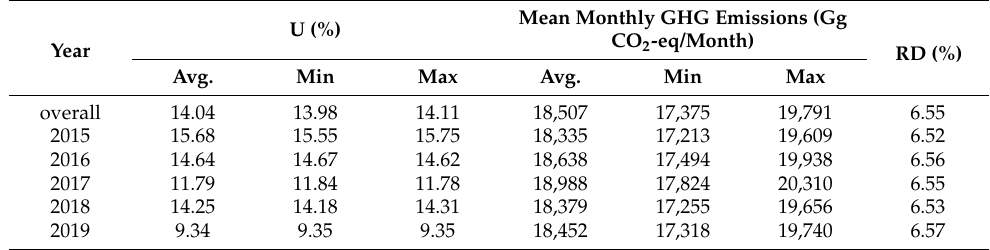
Figure 4. Box plot ( a ) and 95% family-wise confidence level ( b ) Differences in mean levels of Treatment. Table 3. The U, mean, and RD of the monthly GHG emissions based on the average, minimum, and maximum electricity emission